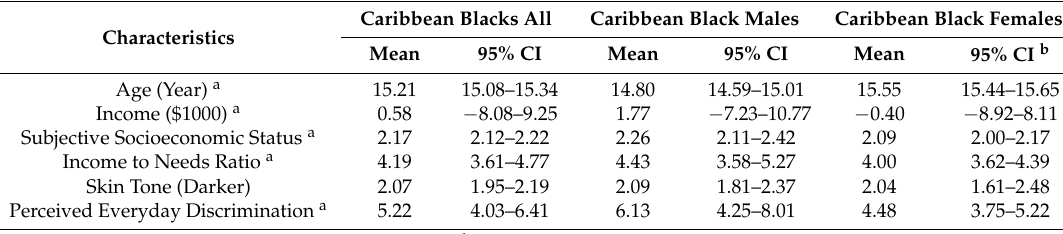
Table 1. Summary of descriptive statistics in the pooled sample of Caribbean Black youth and based on gender.